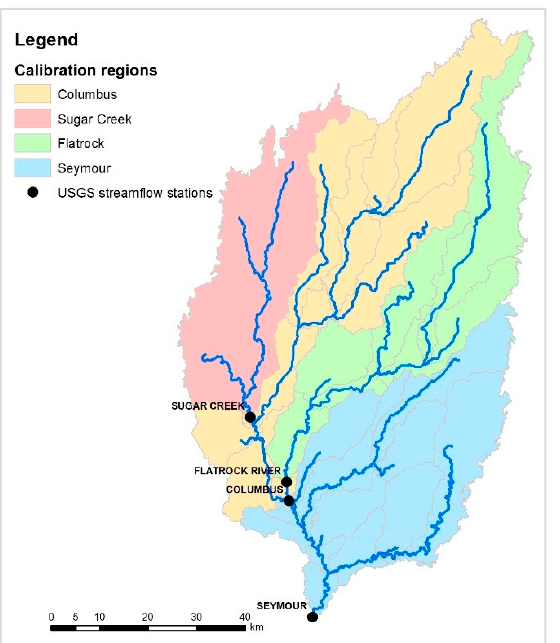
Figure 5. Delineation of the upstream areas, defined by the USGS gauging stations, where calibra- tion phase has been implemented. Table 1. Optimized parameters with the SUFI-2 algorithm implemented in